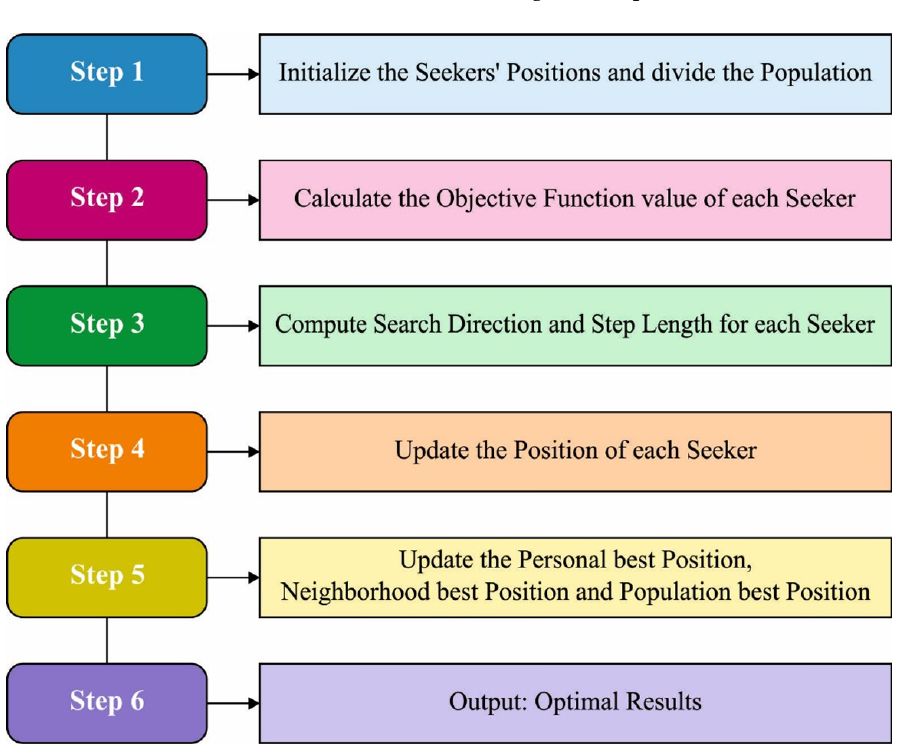
Figure 2. Flowchart of